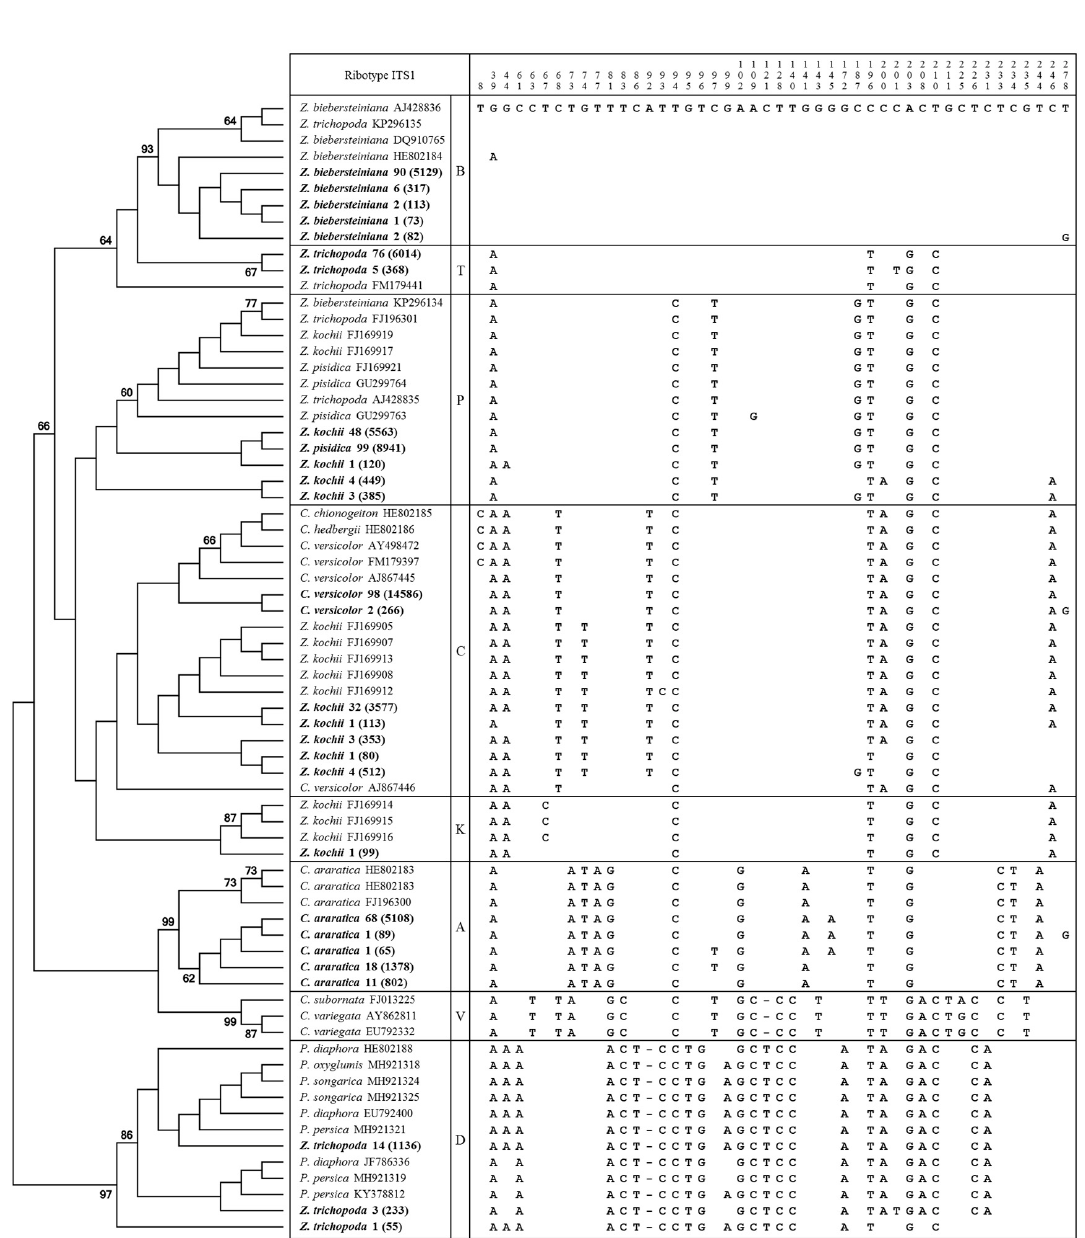
Figure 2. Cladogram and polymorphic nucleotides of ITS1 ribotypes of Zingeria , Colpodium versicolor , and Catabrosella . The percentage of replicate trees in which the associated taxa clustered together in the bootstrap (BS) test are shown next to the branches. The intragenomic ribotypes obtained via NGS are in bold, followed by percentage of the ribotype in the genome and total number of corresponding reads in the